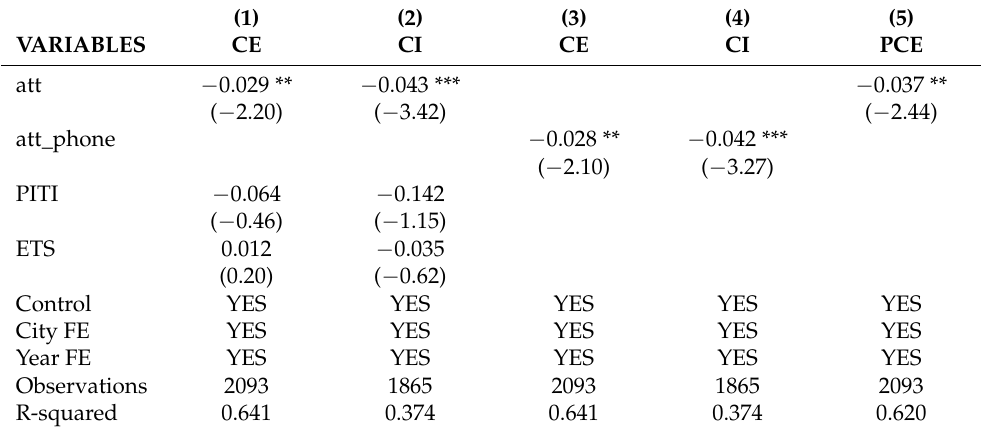
Table 9. Estimation results of excluding other interference policies and replacing the